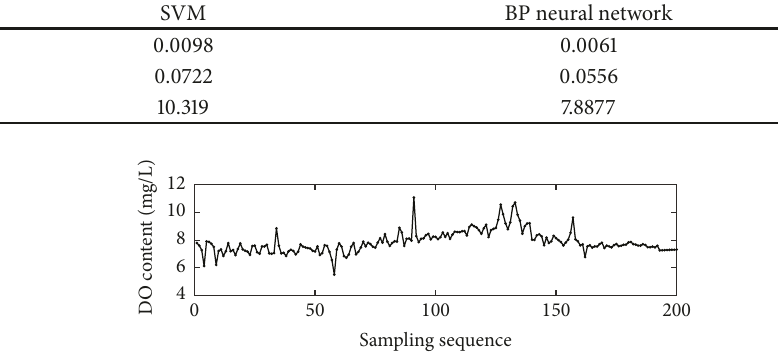
Figure 17: The DO concentration of the monitoring site.